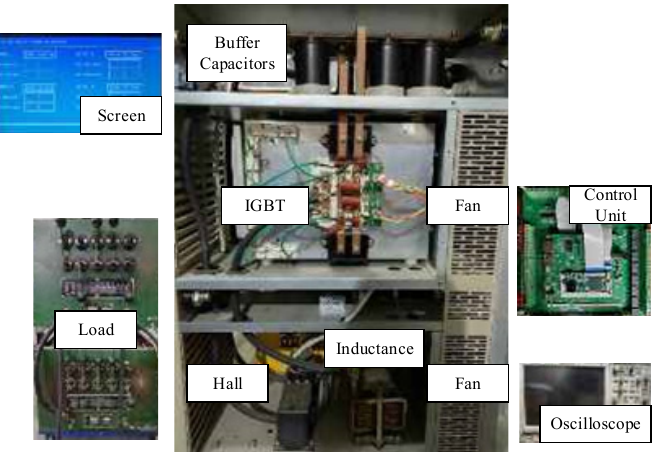
Figure 13. Experimental prototype.